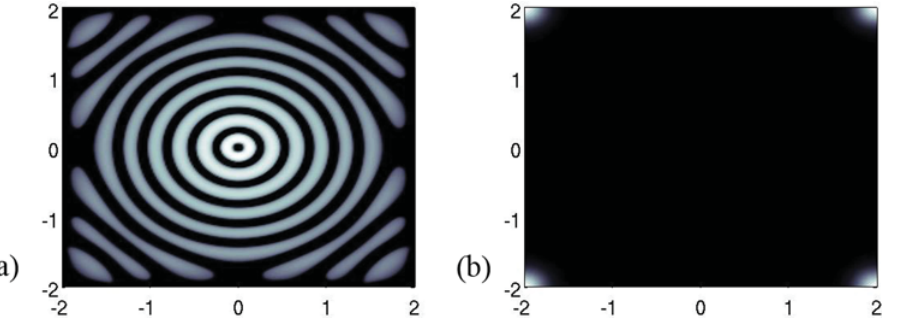
Figure 4. Transition between concentric patterns and plaques is driven by the structural parameter x . Reduced parameters are e˜ =0,2, k / l =4, x˜ =25 (a) and x˜ =8 (b). The pattern diameter is approximatively 4 cm (axis labels in cm s), and the final time is 24 h. These results fit the biological data (see table 2). Destroyed oligodendrocytes are figured in black. The white corners in (b) are boundary artifacts.